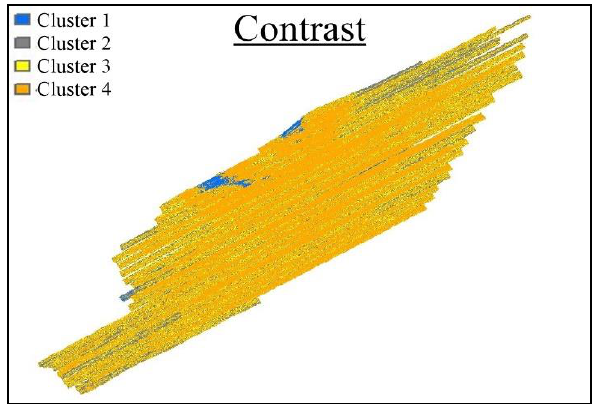
Figure 6: GLCM Contrast Cluster Map